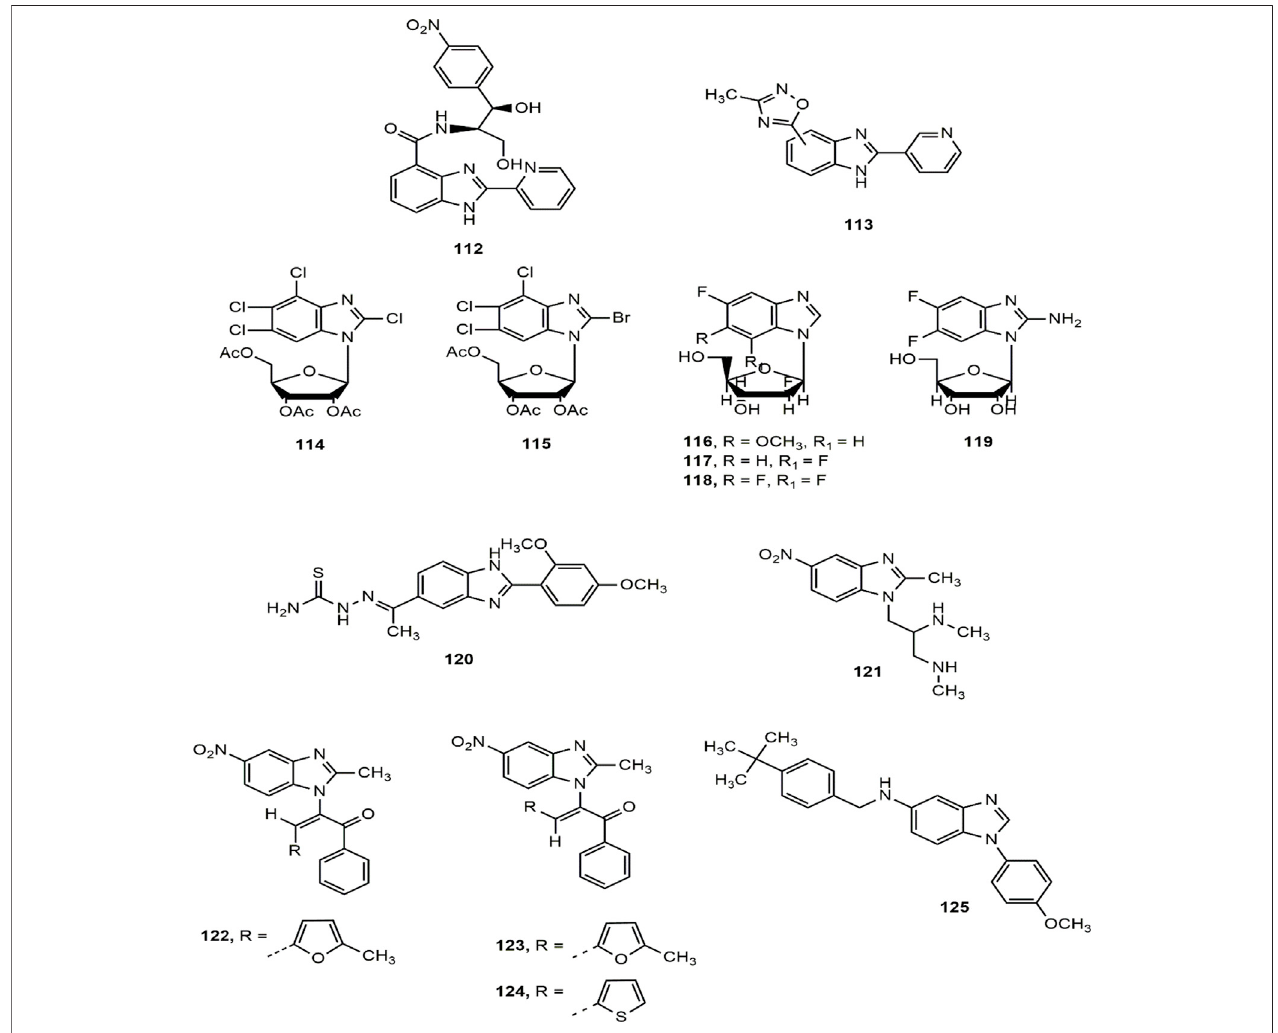
FIGURE 4 | Benzimidazole derivatives with antiviral